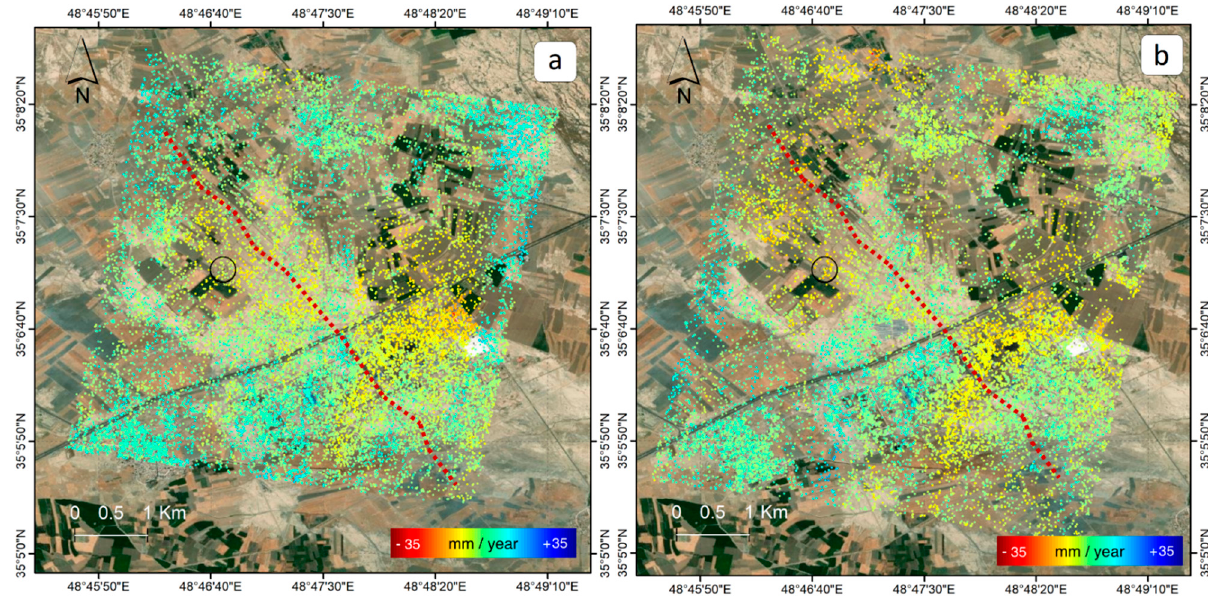
Figure 4. Velocity maps using S-1A for the ( a ) first and ( b ) second group, generated by SARPROZ. The black circle and red dashed line indicate cave area and fault line, respectively.